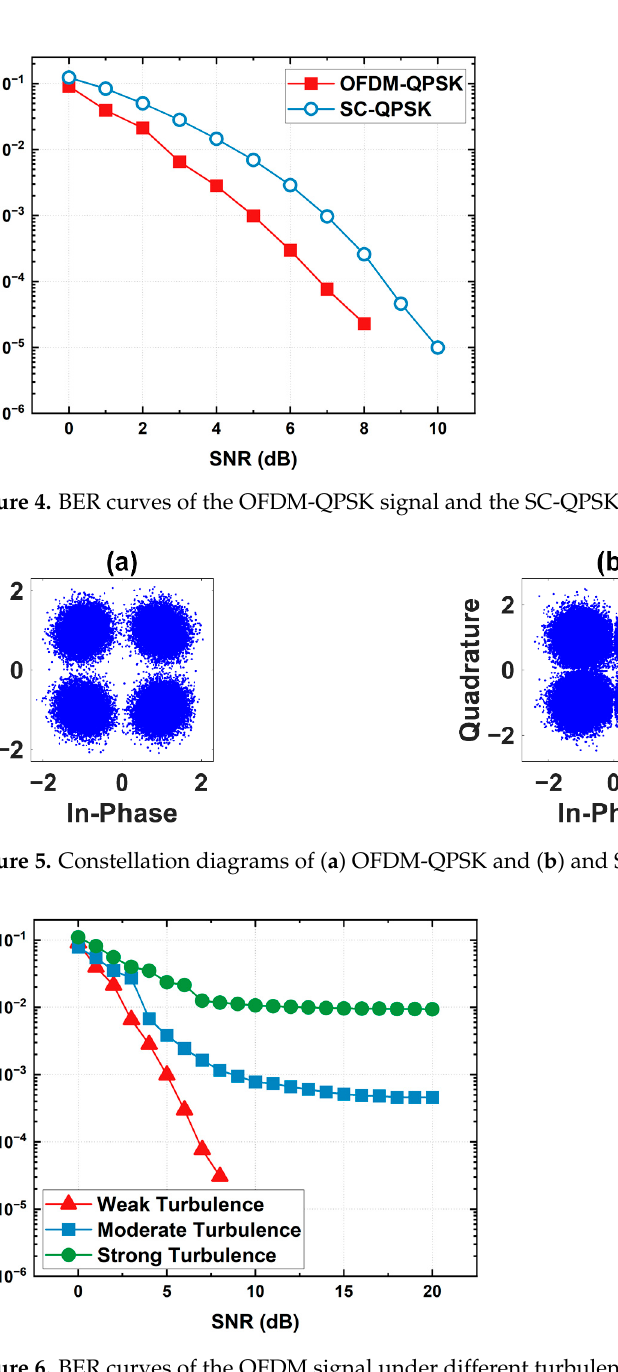
Figure 6. BER curves of the OFDM signal under different turbulence